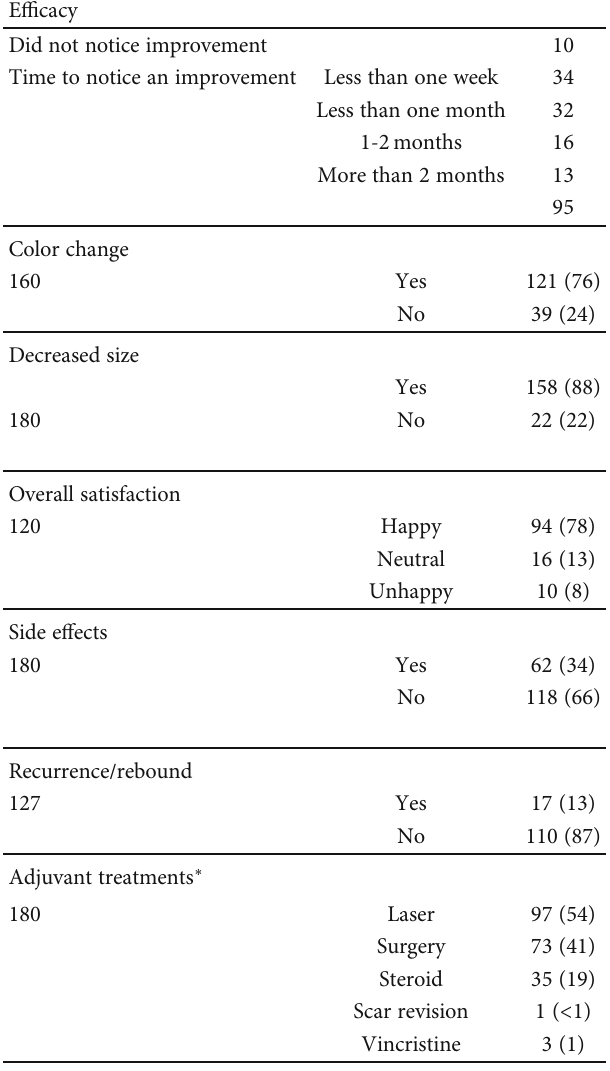
Table 2: Guardian reported side e ff ects. Table 3: E ffi cacy, side e ff ects, and adjuvant therapy of propranolol based on guardian survey. Guardians may not have responded to each survey question thus creating variability in the number of respondents per